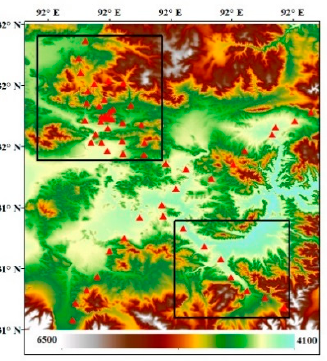
Figure 7. Calibration stations and validation stations, stations in black rectangles are selected as calibration stations and the others as the validation stations.